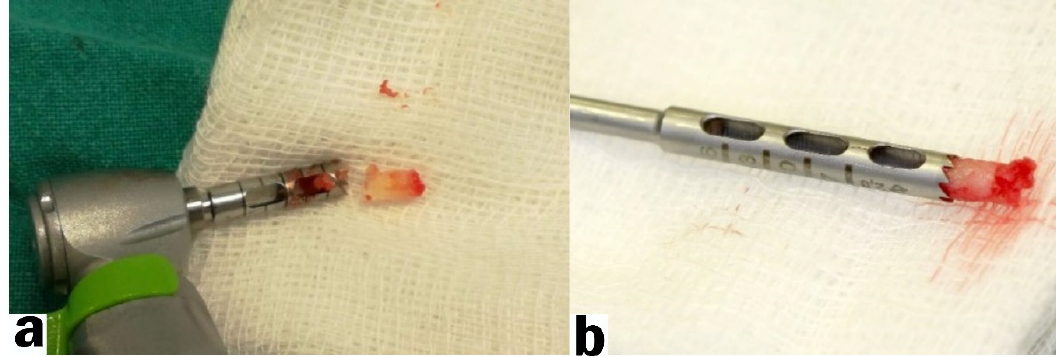
Figure 3 . Bone biopsy: ( a ) harvested bone biopsy; ( b ) bone biopsy in a trephine drill. Figure 3. Bone biopsy: ( a ) harvested bone biopsy; ( b ) bone biopsy in a trephine